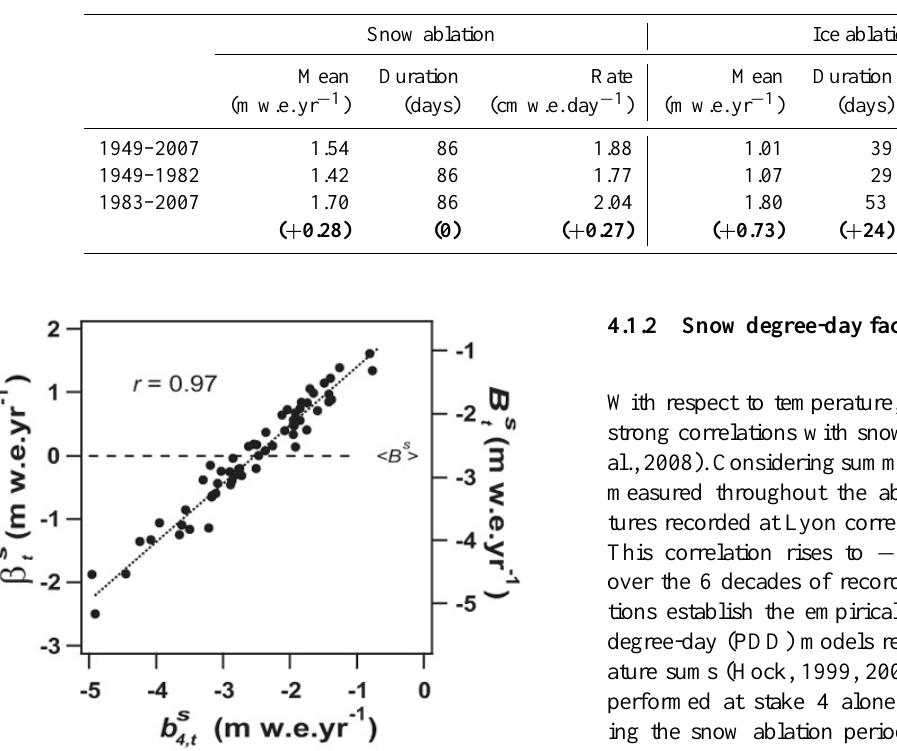
, recorded at this 4 ,t